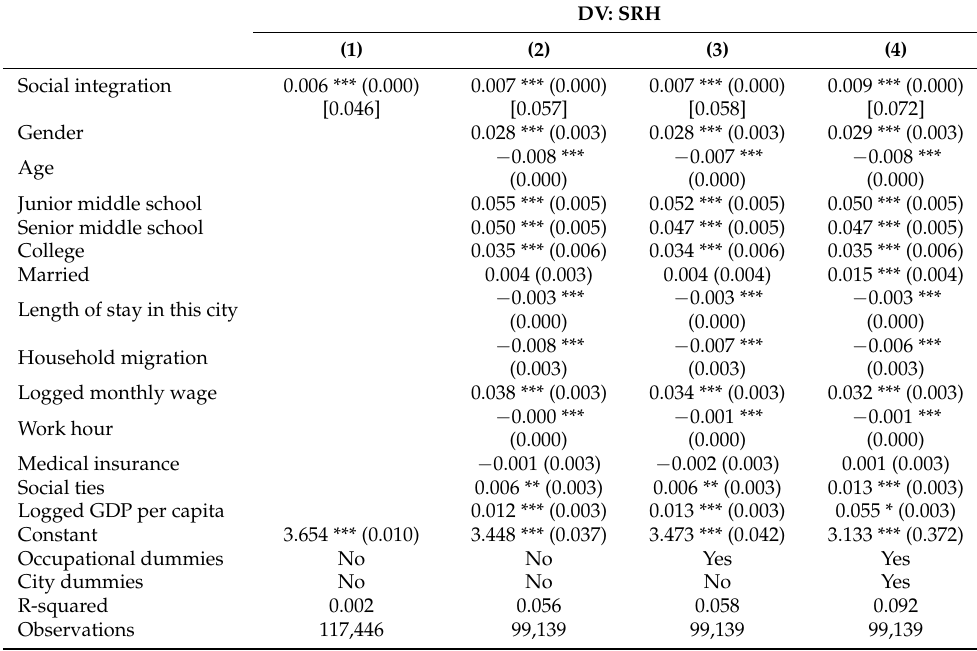
Table 1. OLS estimates for the impact of social integration on